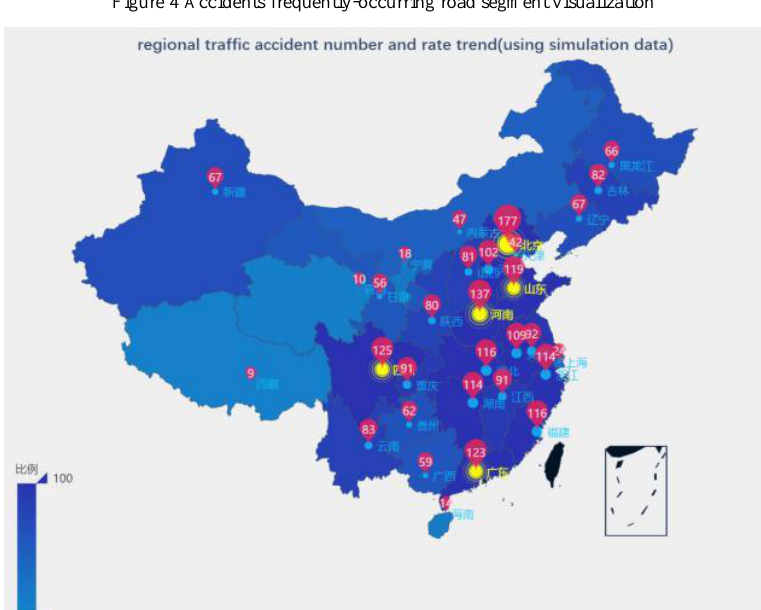
Figure 5 Spatial distribution visualization using reginal hierarchical rendering and scatter plot. c.